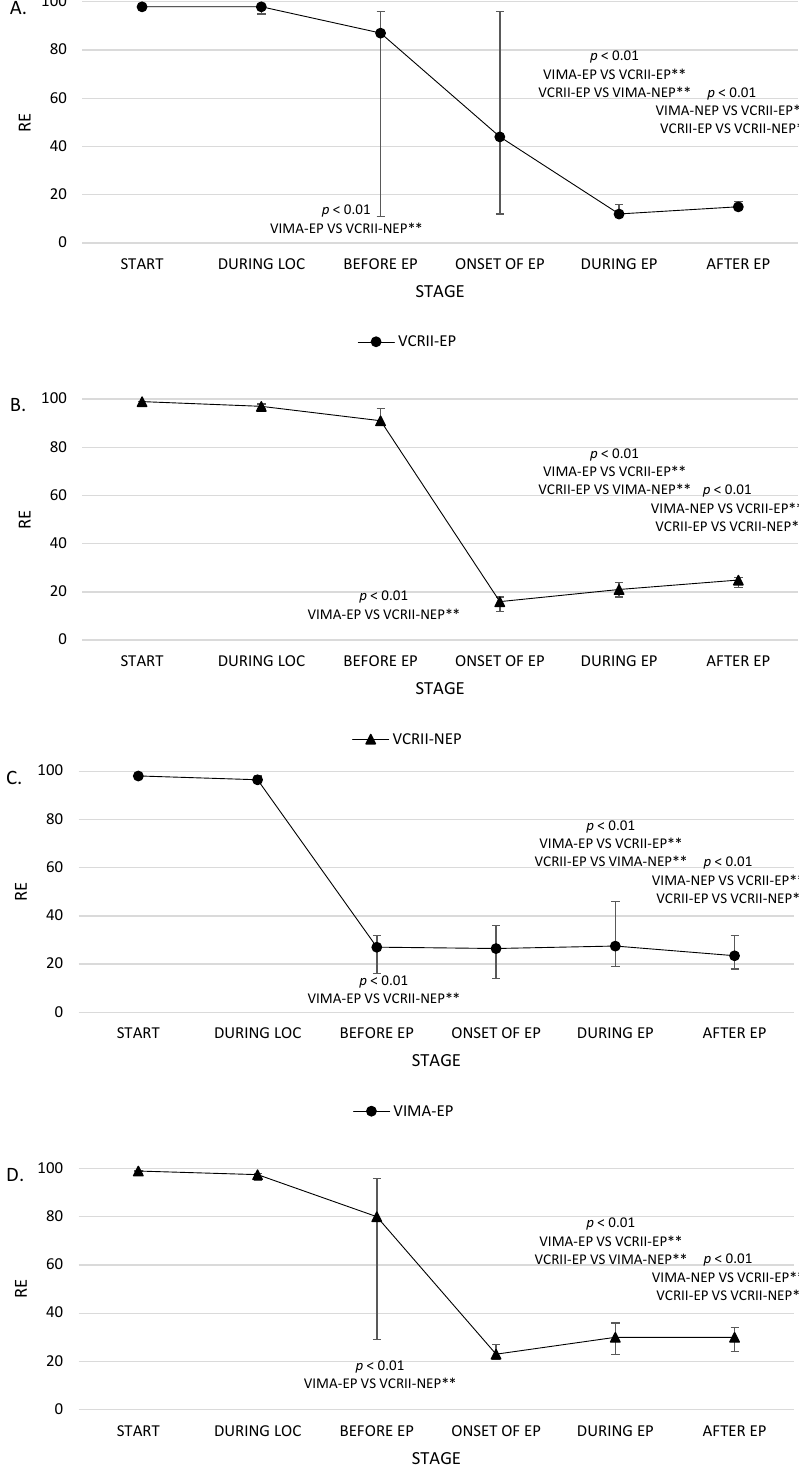
Figure 1. Medians with interquartile range (M (IQR)) of state entropy (SE) in groups: ( A ) volatile- vitalcap-EPI (VCRII-EP), ( B ) volatile-vitalcap-NOTEPI (VCRII-NEP), ( C ) (VIMA-EP), ( D ) (VIMA- NEP), on separate stages of the study, indicating a sequence of events ( p -values: * <0.05, ** <0.01, *** <0.001).